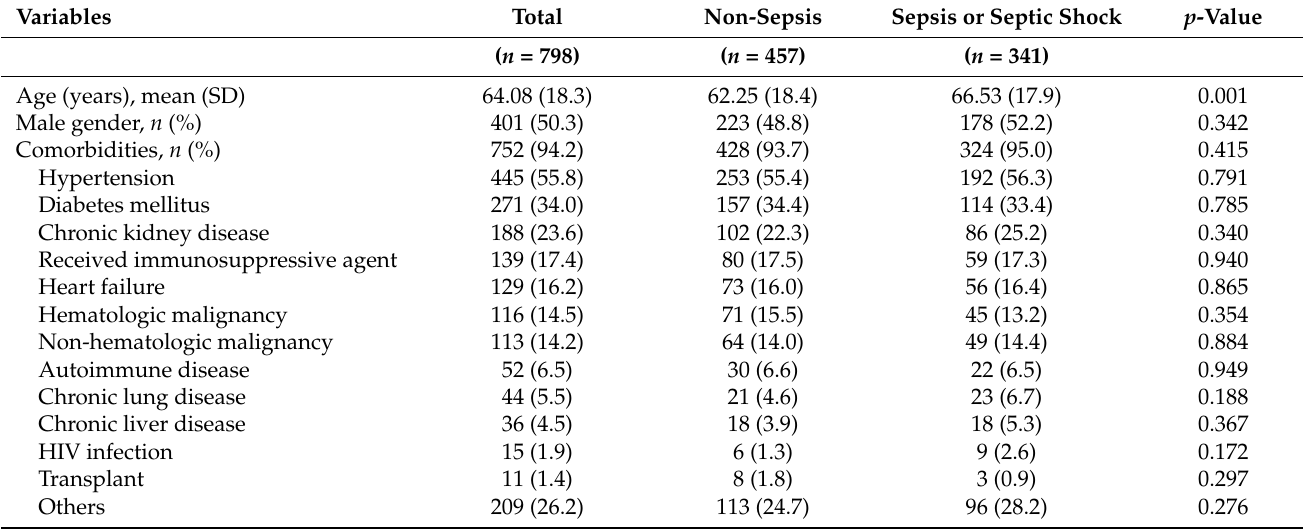
Table 1. Demographics and clinical characteristics of 798 patients with infection who had blood cultures performed, and a comparison between those without sepsis and those with sepsis or septic